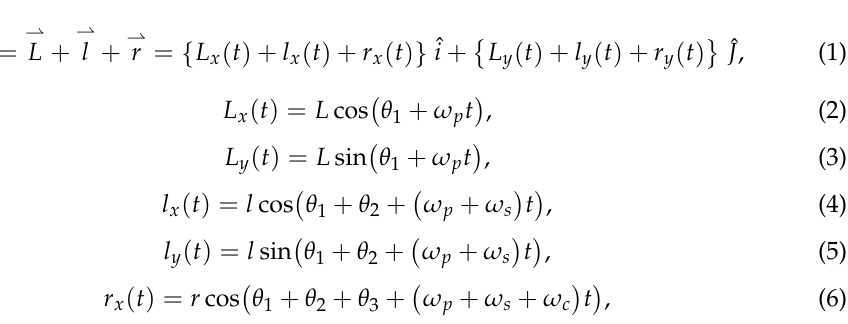
Table 1. Relative occupancy time (ROT, %) of the profile cases; even, linear center fast, linear edge fast, and controlled.